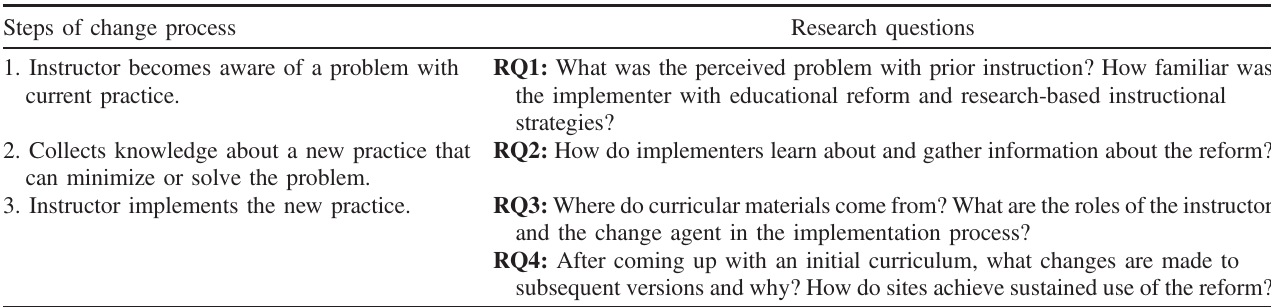
TABLE II. Steps of the change process and related research questions. Steps of change